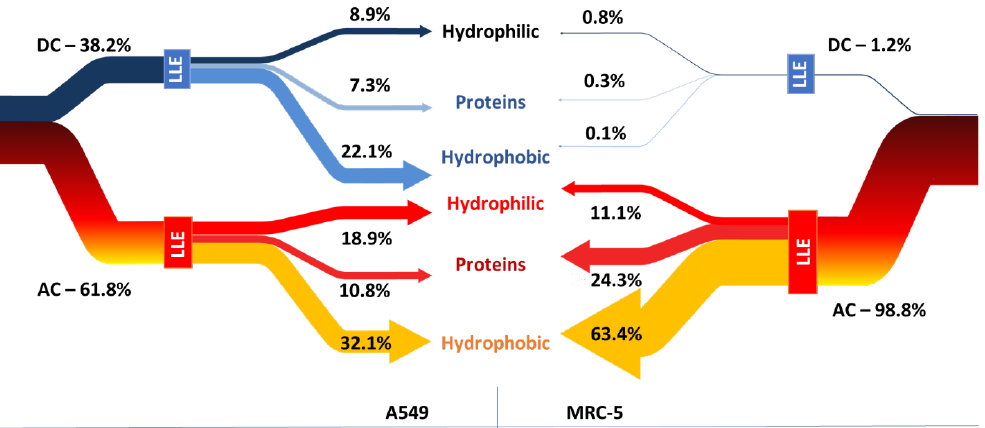
Figure 2. Sankey’s graphs showing the distribution of gold (a characteristic component of auranofin) in three fractions obtained by LLE extraction carried out for adherent (AC) and non-adherent (DC) MRC-5 and A-549 cells.